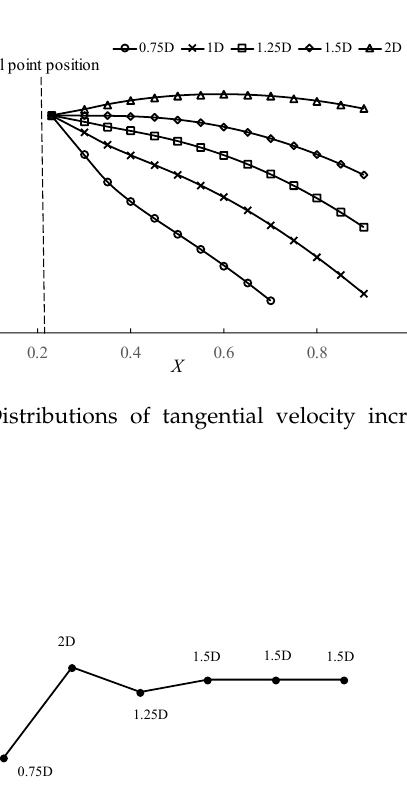
Figure 4. Simulation results for a circular cylinder at Re = 1 × 10 7 ： ( a ) flow field around the circular cylinder; ( b ) pressure distribution on half of the cylinder.